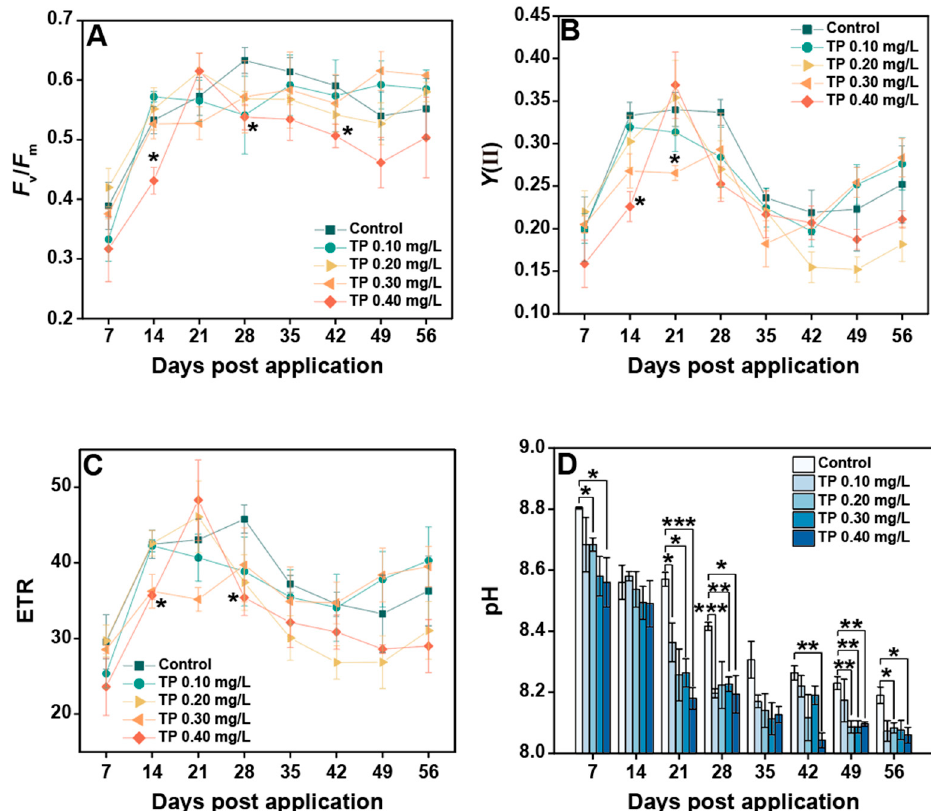
Figure 7. Changes in plankton community functional parameters under different TP treatments. ( A – D ) represents F v / F m , Y (II), ETR, and pH, respectively. Significant differences are indicated in the figure, p ≤ 0.05 is marked as *, p ≤ 0.01 is marked as **, and p ≤ 0.001 is marked as ***.